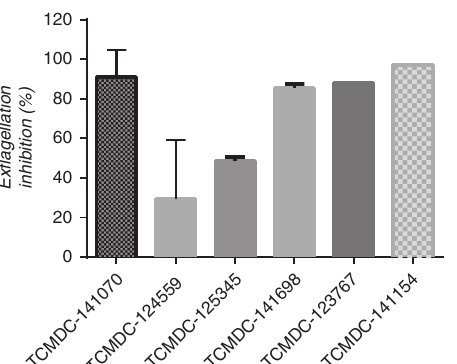
Figure 5 | Exflagellation inhibition by six TCAMS compounds. Stage V gametocyte cultures were exposed to 2 m M of TCMDC-141070 and 1 m M of the five remaining compounds for 48h. The percentage inhibition was determined compared to DMSO-treated controls. Compounds were then progressed into SMFA to further determine the transmission blocking in mosquitoes. Each bar represents mean value of two (TCMDC-125345, TCMDC-141698, TCMDC-123767, TCMDC-141154) or three (TCMDC- 141070, TCMDC-124559) independent replicates with s.d.